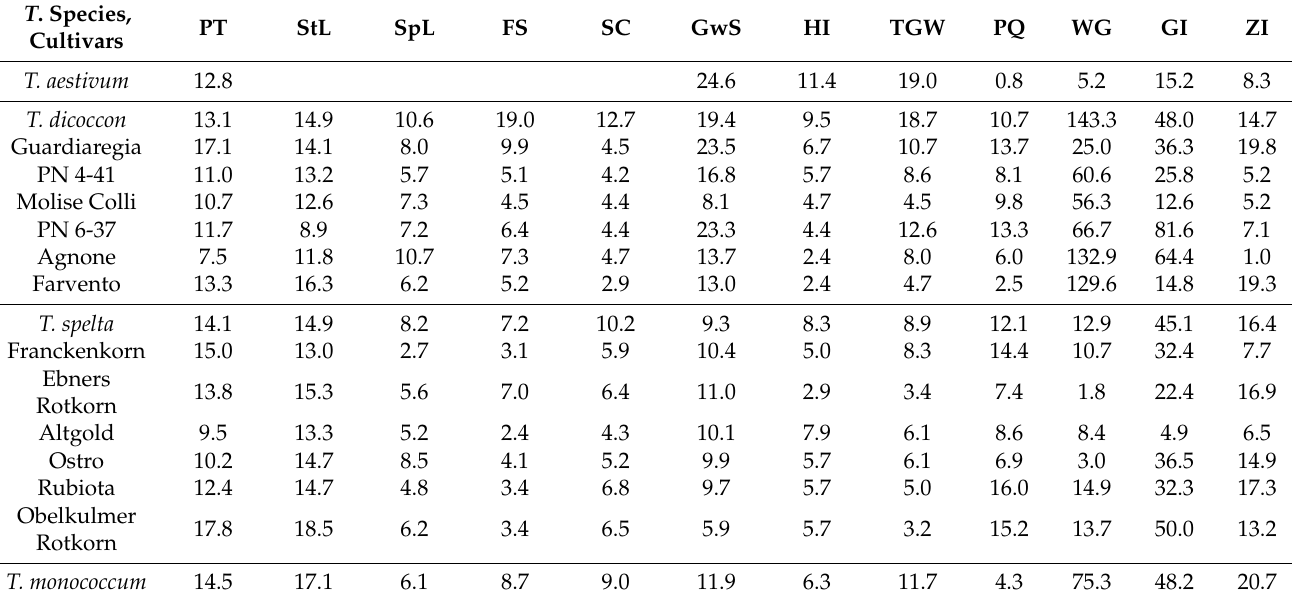
Table 4. Coefficients of variation for agro-morphological and grain quality traits of T . species and